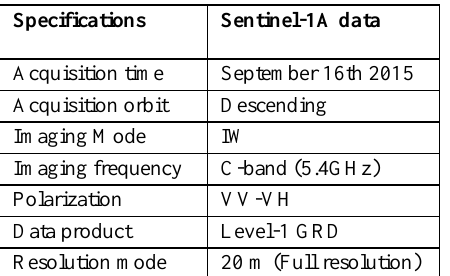
Table 1. Specifications of Sentinel-1A